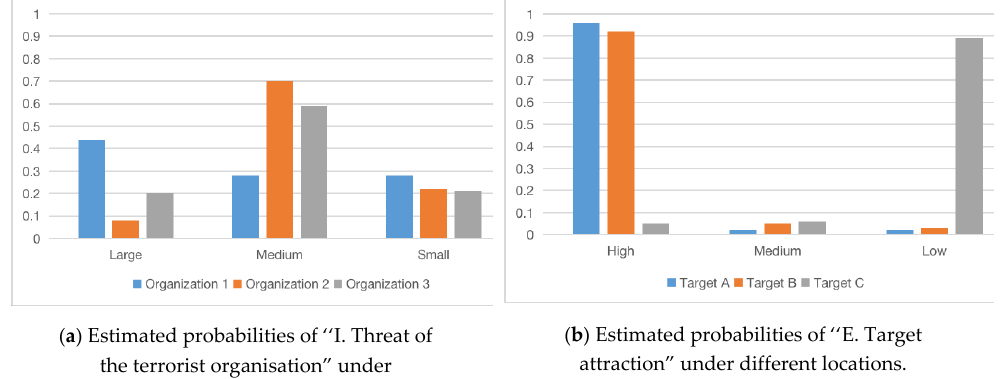
Figure 4. Node status of Target A in Bayesian network.